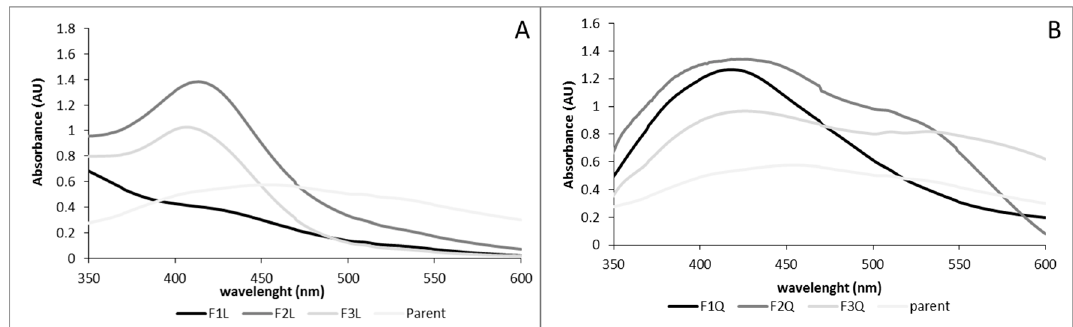
Figure 2. Ultraviolet–visible (UV–Vis) spectra of AgNPs synthesized using different low molecular weight chitosan fractions as reducing and stabilizing agent. ( A ) Chitosan depolymerized using chitosanase and ( B ) chitosan depolymerized using lysozyme. In both figures, the UV–Vis spectrum of the parent chitosan has been added for comparison.